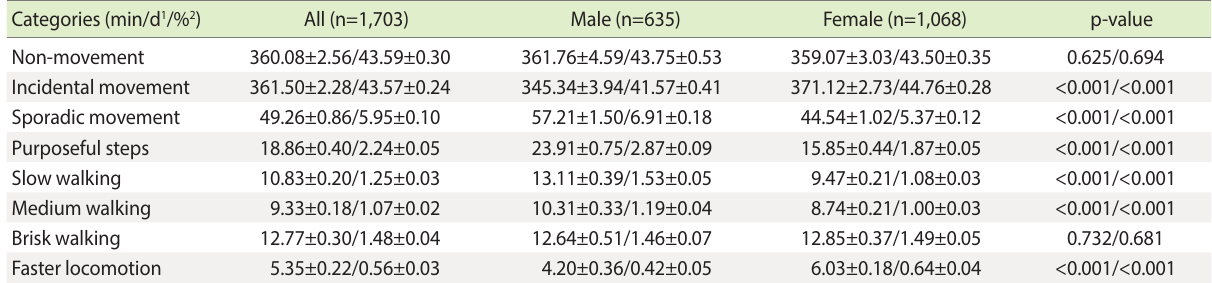
Table 2. Spent time (absolute and percentage value) in cadence categories during wearing time by sex Categories (min/d 1 /% 2